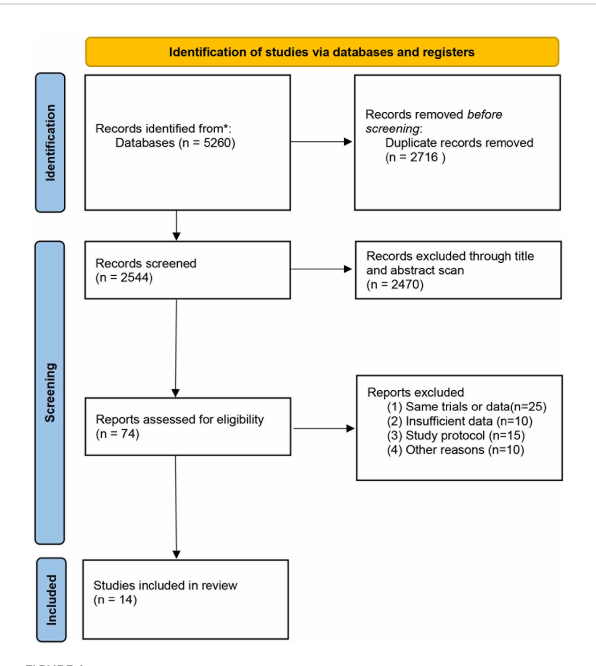
FIGURE 1 Flow diagram of selection of eligible